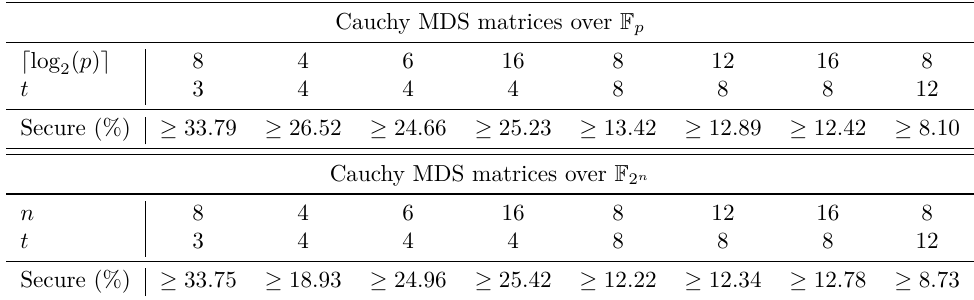
Table 5: Percentages of Cauchy MDS matrices fulfilling the requirement in Proposition 13. Cauchy MDS matrices over F